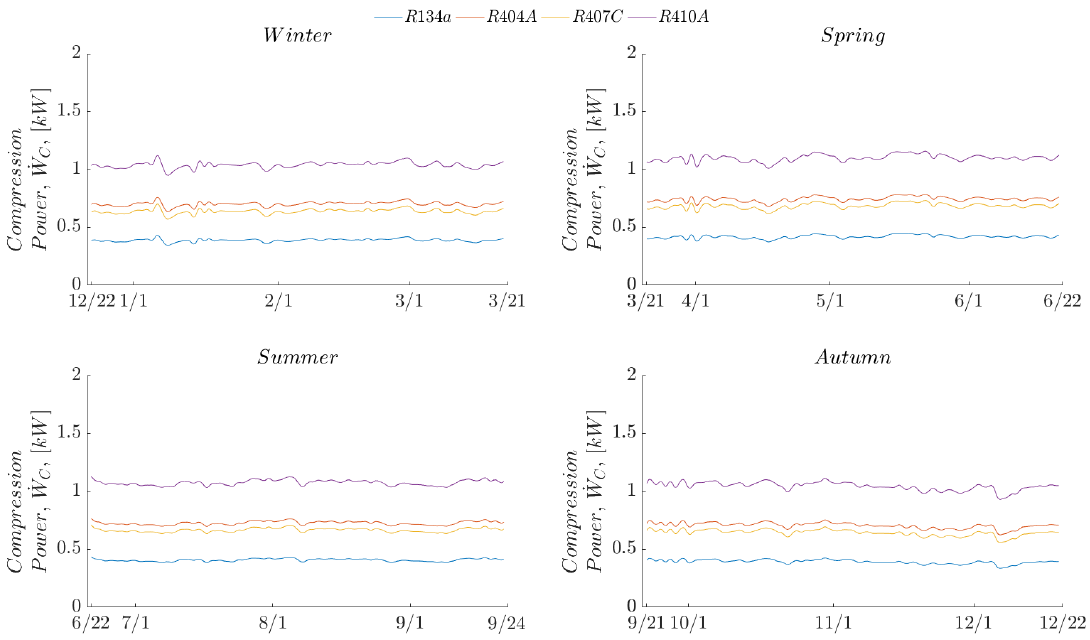
Figure 23. Seasonal compression power input of the optimized system for all refrigerants.